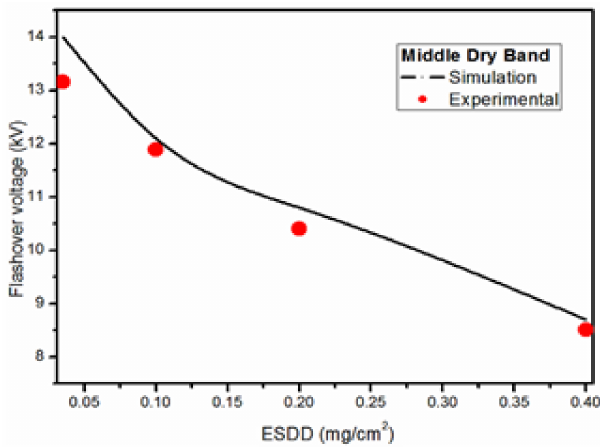
Figure 20. Flashover voltage for a middle dry band configuration at different values of ESDD.